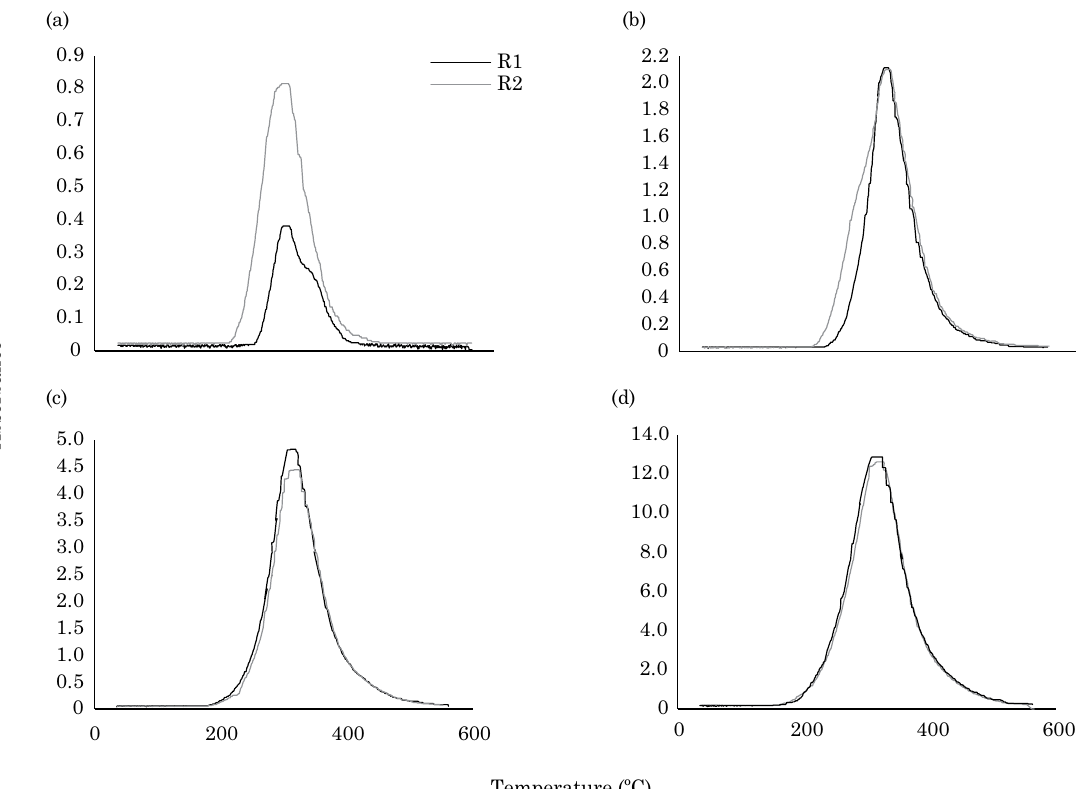
figure 5. thermograms of samples of typic rhodudalf (nvef) soil subjected to adsorption of hg 2+ solution at the following concentrations: (a) 0.1000 μg mL -1 , (b) 0.5000 μg mL -1 , (c) 1.000 μg mL -1 , and (d) 2.000 μg mL -1 . in the key, r1 and r2 represent replicates 1 and 2, respectively, measured on different